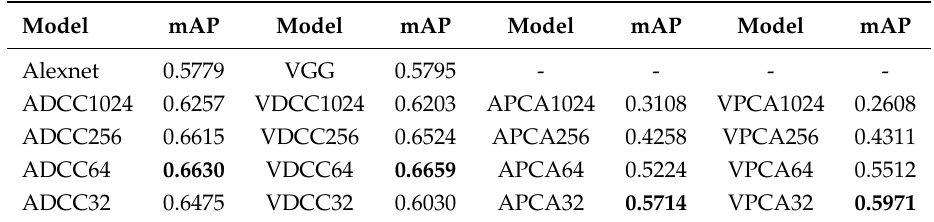
Table 13. Comparison of the retrieval mAP values of the DCC and DPCA